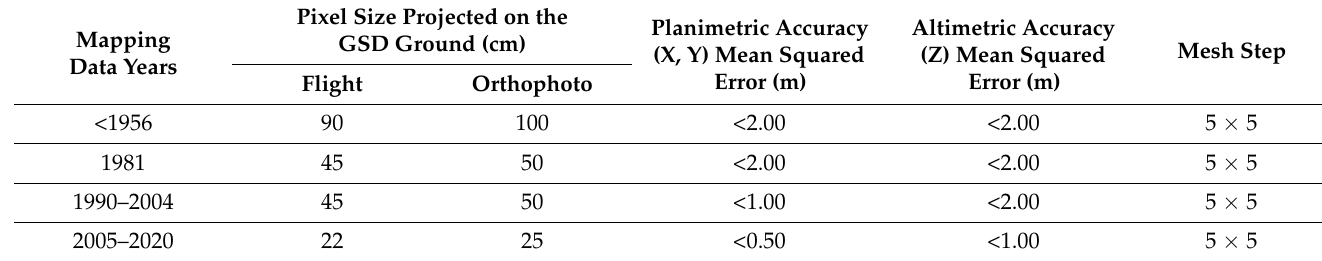
Table 2. Technical characteristics of georeferenced spatial data